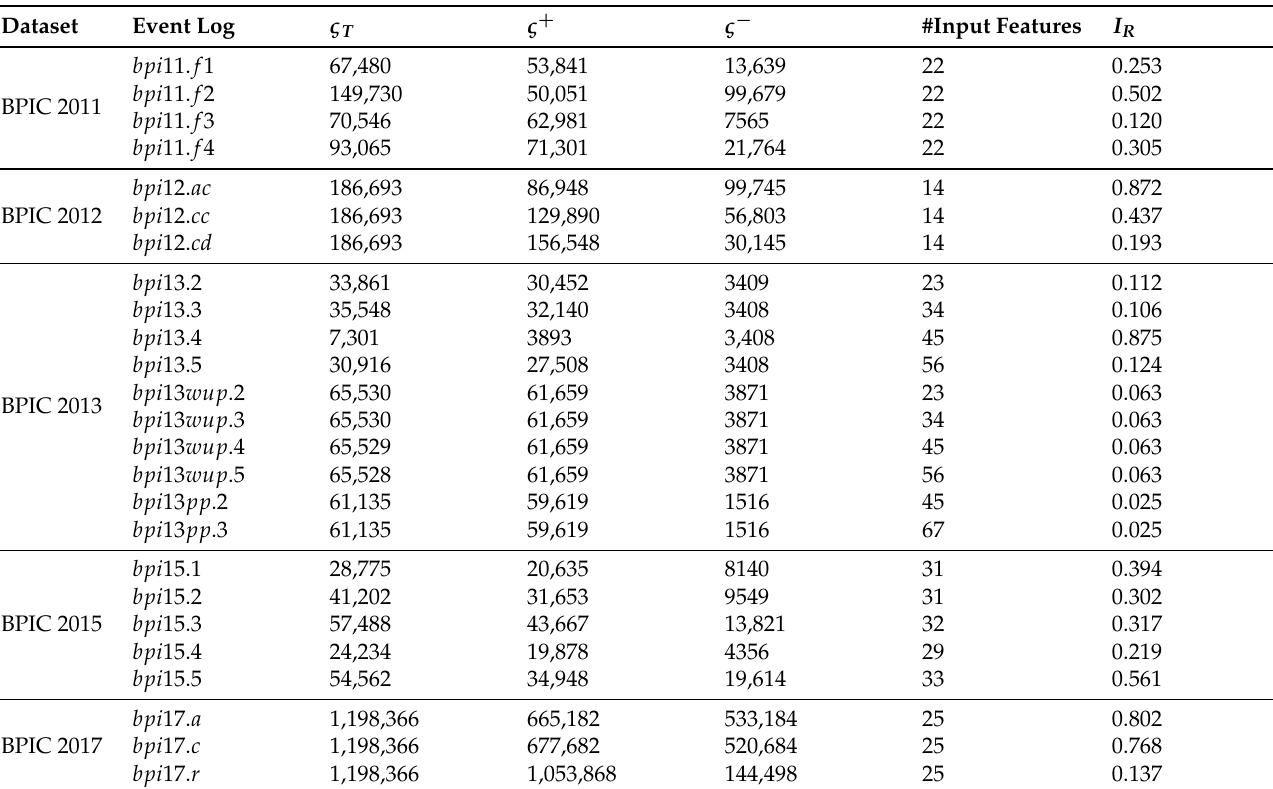
Table 1. The characteristics of event log datasets employed in this study. A severely imbalanced dataset occurs when I R <